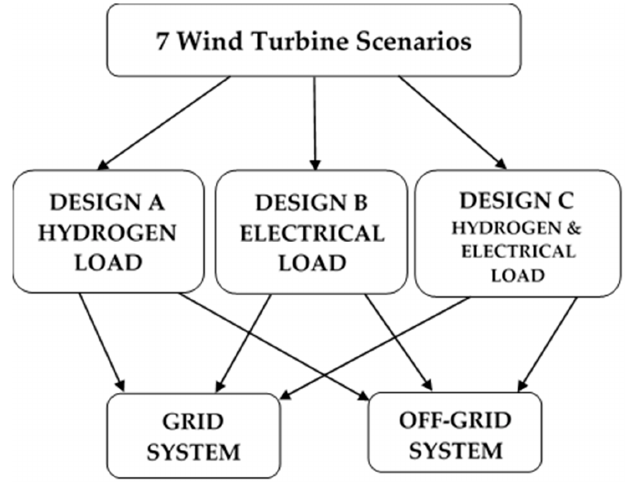
Figure 7. Scenarios’ flowchart for the HOMER analysis.